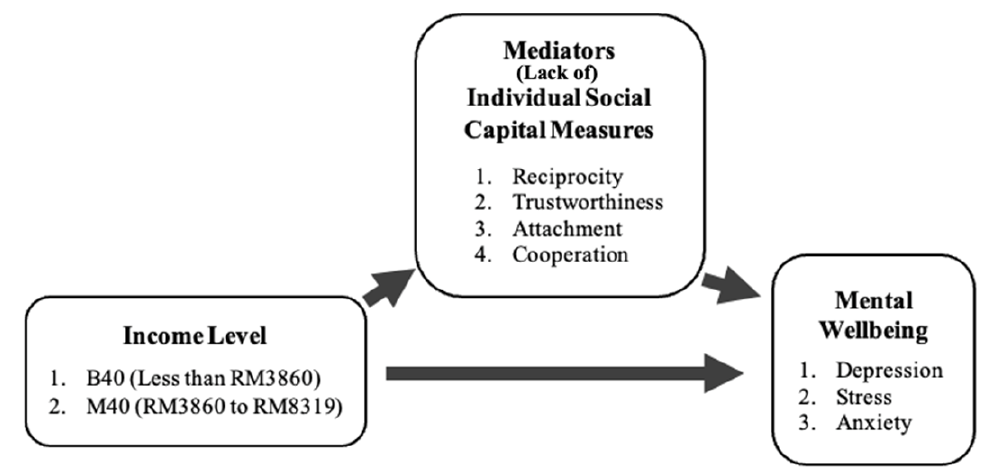
Figure 1. Framework of the mediation analysis.